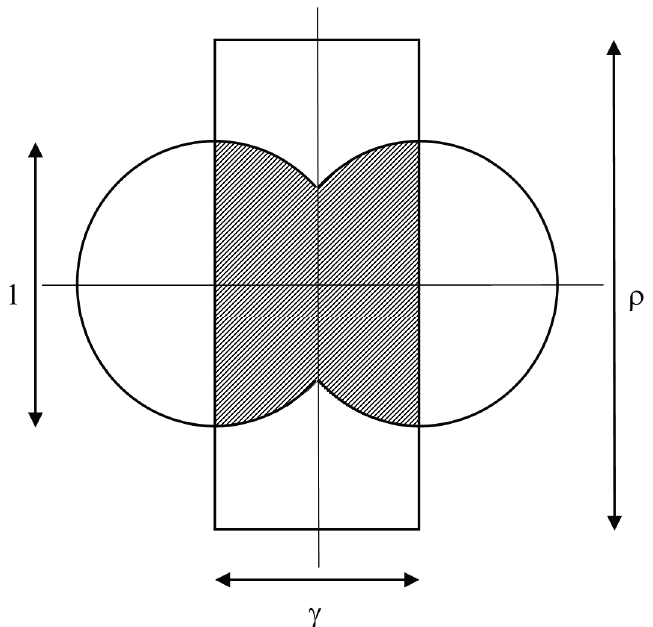
Figure 5. The shaded area shows the region in which a target center can lie for the target to be successfully hit, whereas the rectangular area is the swath swept out by an actuator, travelling left to right, during the time between fire commands.